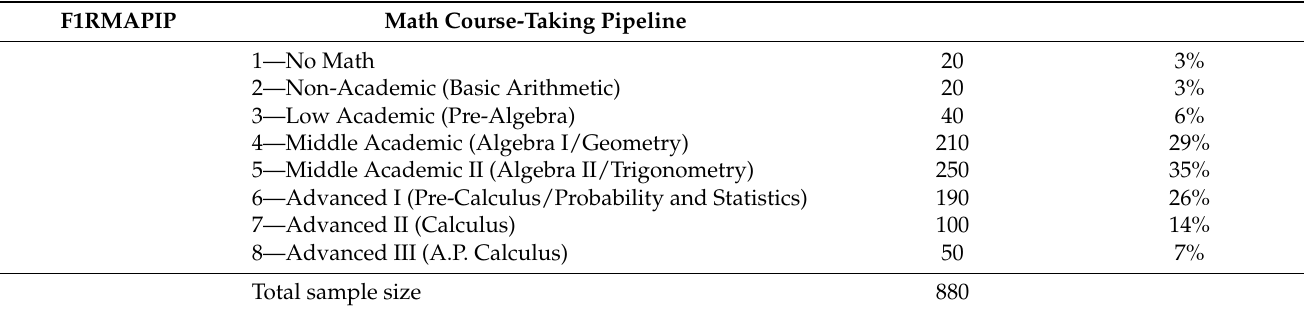
Table 1. Distribution of highest level of math completed (math course-taking pipeline).